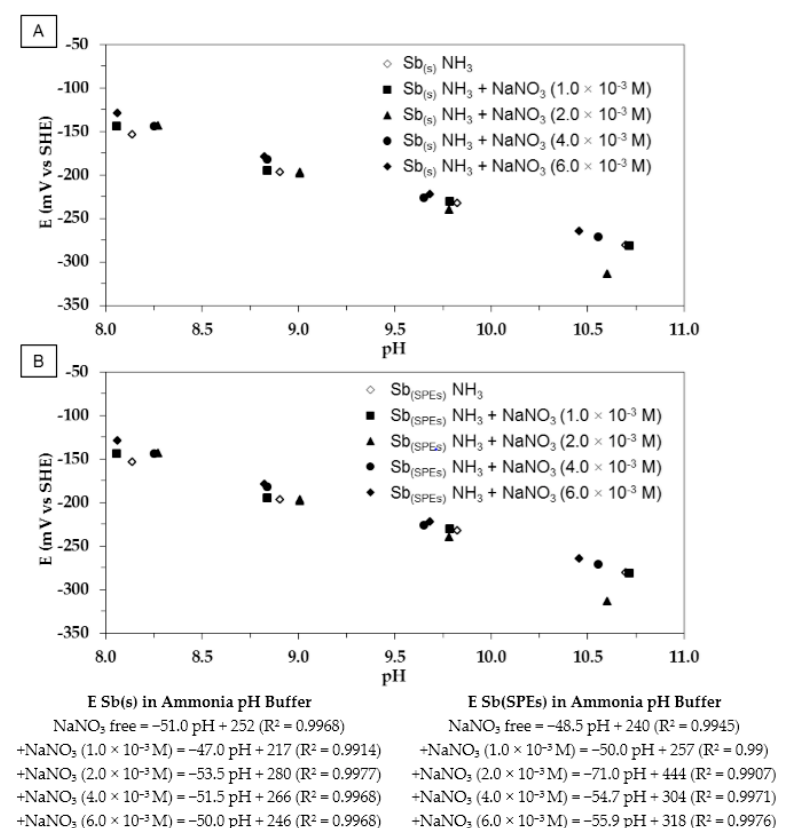
Figure 5. Eh-pH diagram of both Sb(s) ( A ) and Sb(SPEs) ( B ). Experiments were done at 25 °C, at atmospheric pressure, in ammonia pH buffer solutions (IS = 0.1) containing NaNO 3 (0, 1.0 × 10 − 3 , 2.0 × 10 − 3 , 4.0 × 10 − 3 and 6.0 × 10 − 3